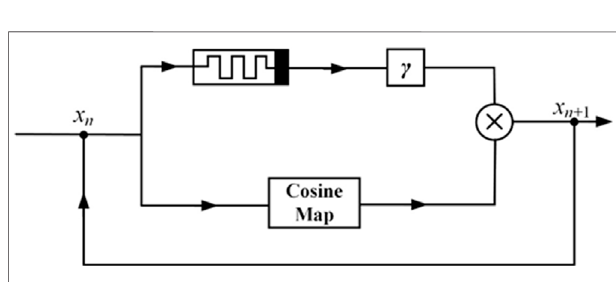
FIGURE 2 | Structural diagram of the cosine map coupled by the discrete